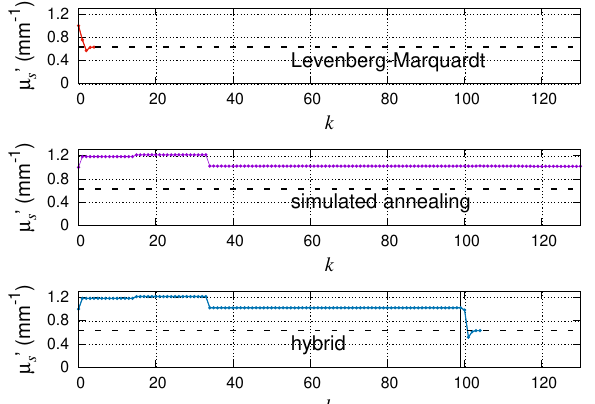
Figure 3. Case 1: Reconstructed µ a by (top) Algorithm 1, (middle) Algorithm 2, and (bottom) Algorithm 3. The dashed lines show µ a in Equation (42).